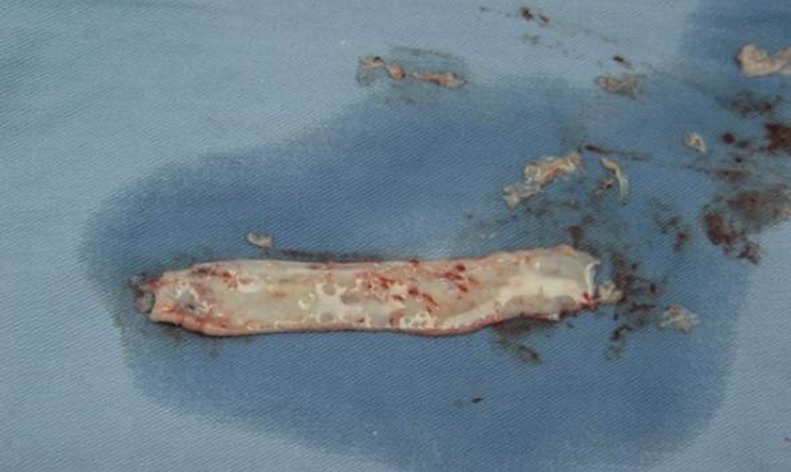
Graft defatting.